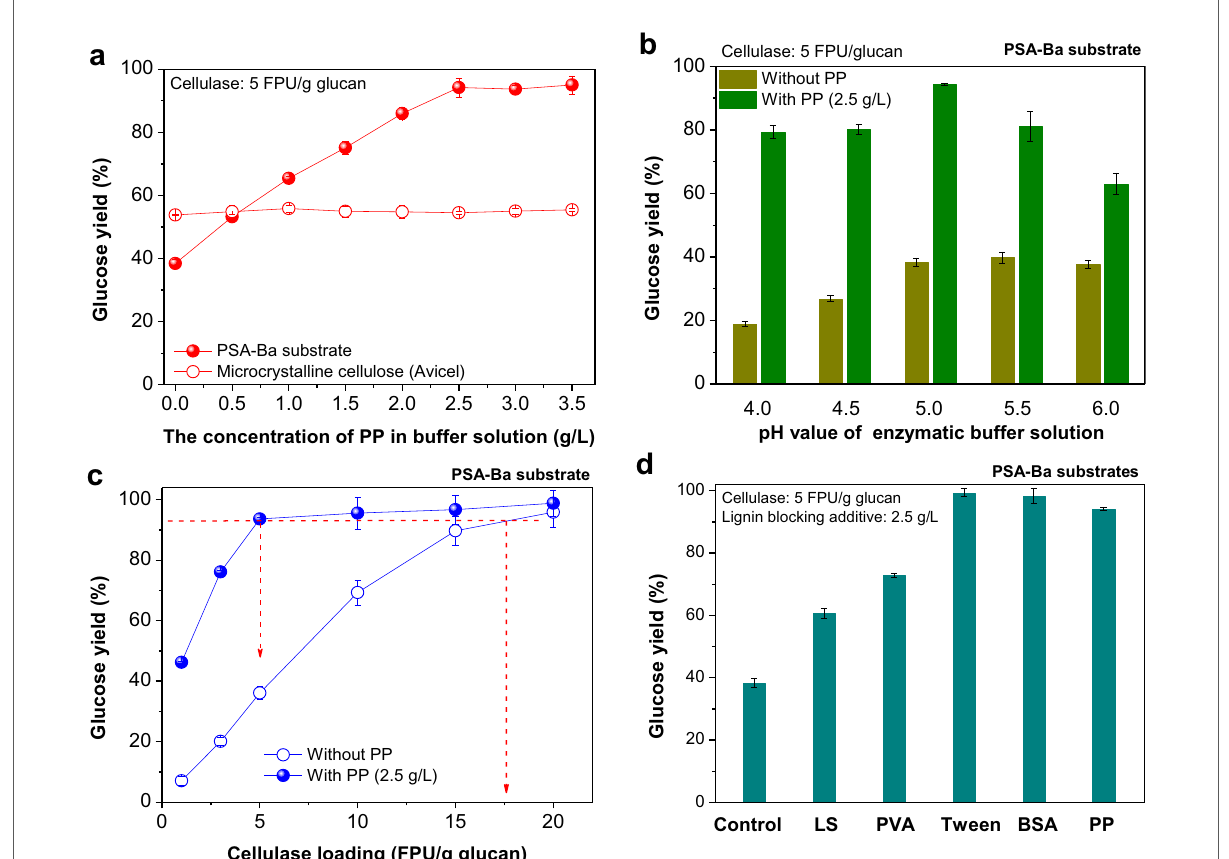
Fig. 3 Effects of a PP loading, b the pH value of buffer solution, c cellulase loading and d different lignin-blocking additives on the glucose yields of PSA-Ba substrate or microcrystalline cellulose (Avicel). The pH value of the enzymatic buffer solution used in a , c and d was 5. The β-glucosidase loadings used in a , b and d were 10 CBU/g glucan. For each enzymatic hydrolysis experiment conducted in c , the amount of β-glucosidase (CBU/g glucan) is twice the cellulase loading (FPU/g